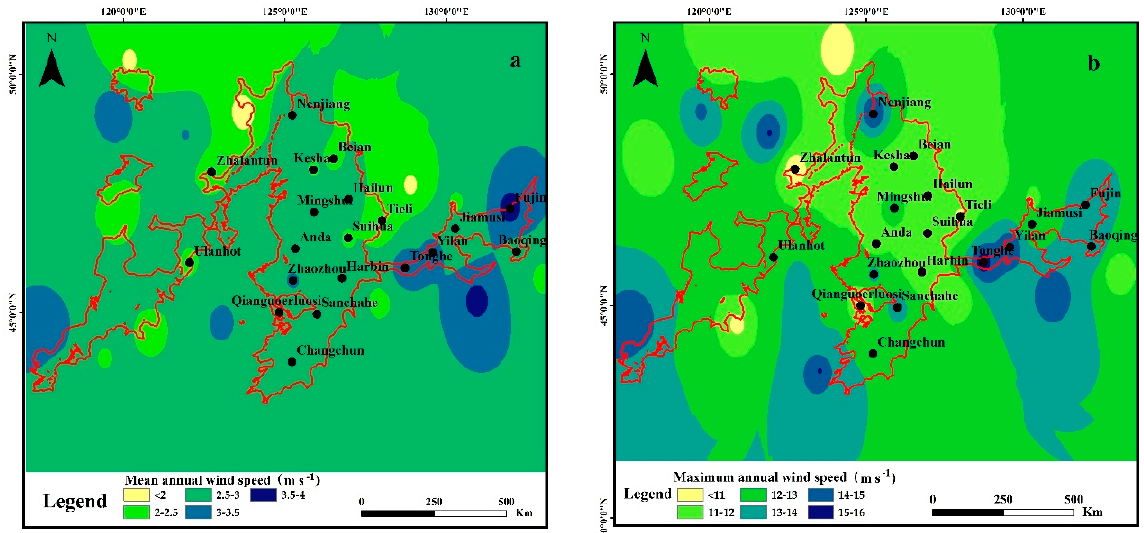
Figure 7. Spatial distribution of the wind speed in the water erosion area of the typical black soil region (( a ): mean annual wind speed, ( b ): maximum annual wind speed). The maximum annual wind speed in the water erosion area of the typical black soil region showed the decreasing trend as east > west > middle in general. The maximum annual wind speed in the East showed the highest value (15–16 m s − 1 ) around Yilan and Tonghe meteorological stations, which was consistent with the highest value of the mean annual wind speed. The maximum annual wind speed in the west ranged at 12–13 m s − 1 without great variations (16.6%). Compared with the east and west of the study area, the maximum annual wind speed showed higher spatial variation (50.4%) in the middle region, with a trend of first decreasing and then increasing from south to north. The east of the study area was located at the junction of Lesser Khingan Mountains and Changbai Mountains, where the higher near-surface wind speed is mainly due to the narrow tube effects in the local wind zone [44]. Affected by the altitude and terrain factors, the air flow is blocked and the maximum wind speed fluctuation is not obvious in the west of the study area, which is located in the Greater Khingan Mountains [46]. Compared with Figures 5 and 7, it was noticeable that the wind speed in the middle of the study area is relatively small, but the change of both mean annual wind speed and maximum annual wind speed here showed upward trends. The influence of the wind speed in the middle of the study area should be concerned in the future. 3.2.2. Spatial Variation of Wind Speed in April and May The spatial variation of the maximum monthly wind speed was specifically investigated in April and May (Figure 8), as it showed the highest value in these two months according to its seasonal variation characteristics in the study area. The maximum wind speed in April and May was higher in the east, southern, and northern sites of the study area, with a decreasing trend from east to west and south to north on the whole. There are three high values of the maximum speed (Figure 8a) in April, as: (i) the area around Yilan and Tonghe meteorological station in the east; (ii) the area around Nenjiang and Changchun meteorological station in the southern and northern sites of the middle; (iii) the area around Linxi meteorological station in the southern side of the west region. As shown in Figure 8b, compared with the maximum wind speed distribution in April, the maximum wind speed in May did not change greatly in the east, but significantly decreased in the area around Beian meteorological station in the north site of the middle study area, and increased significantly around Sanchahe station in the south side. Moreover, the wind speed decreased obviously in the west of the study area.